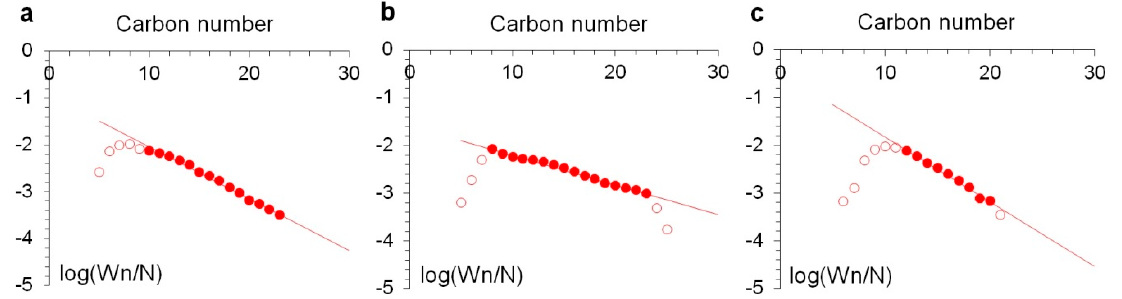
Figure 5. Anderson–Schulz–Flory (ASF) plots of hydrocarbon formation over HNT@Ru-1 ( a ), HNT@Ru-2 ( b ), and HNT@Ru-3 ( c ).